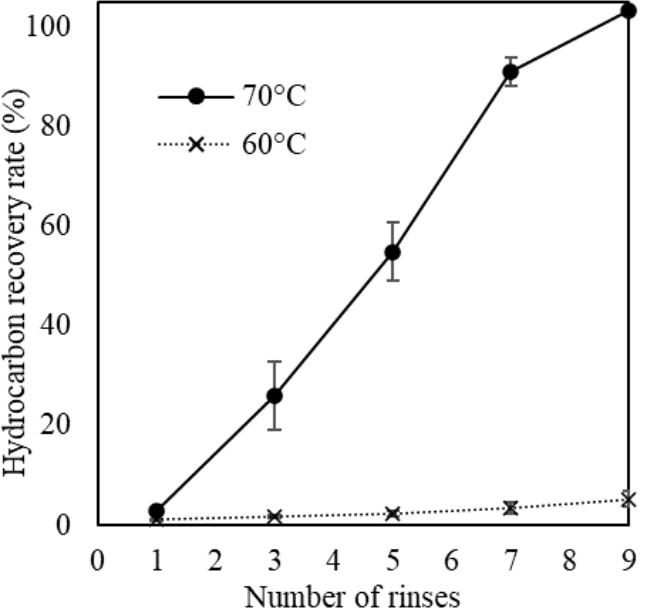
Figure 3. Effect of the number of rinses with hot-water at 60 °C and 70 °C on hydrocarbon recovery rate ( n = 3, mean ± SD).